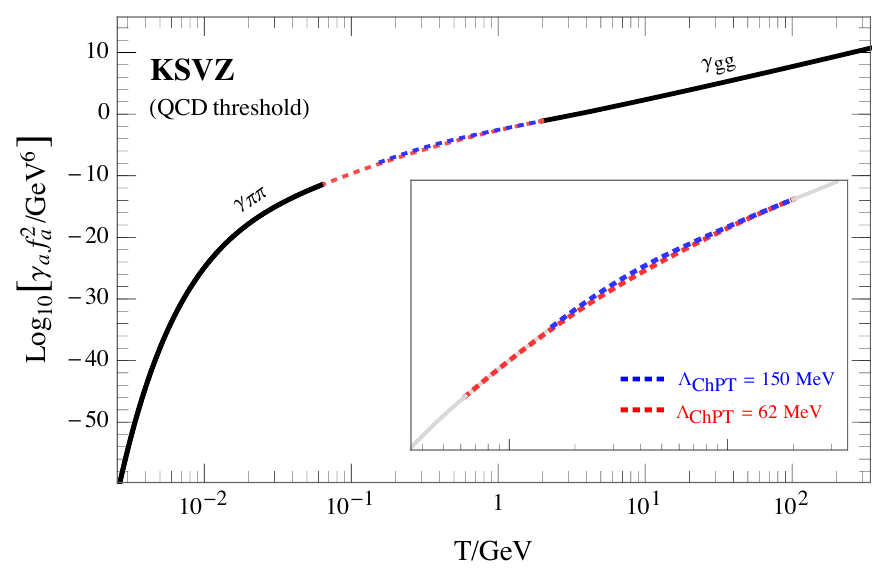
Figure 3 . KSVZ axion production rate across the QCDPT. Pion scatterings dominate at low temperatures ( T . Λ ) whereas thermal gluon scatterings control the rate where QCD is ChPT perturbative ( T & Λ ). We interpolate between these two regimes for the two different values N Λ = 62 MeV (dashed red) and 150 MeV (dashed ChPT